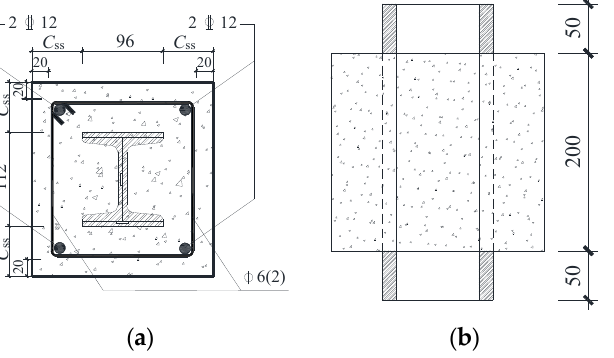
Figure 1. Design dimensions of typical RCES specimen, they should be listed as: ( a ) Cross ‐ section of typical RCES specimen; ( b ) elevation of typical RCES specimen.